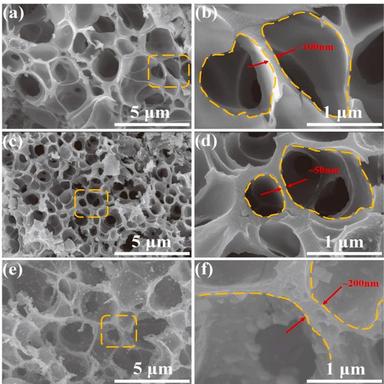
SEM images of (a, b) ZFO/C-400, (c, d) ZFO/C-450, and (e, f) ZFO/C-500.